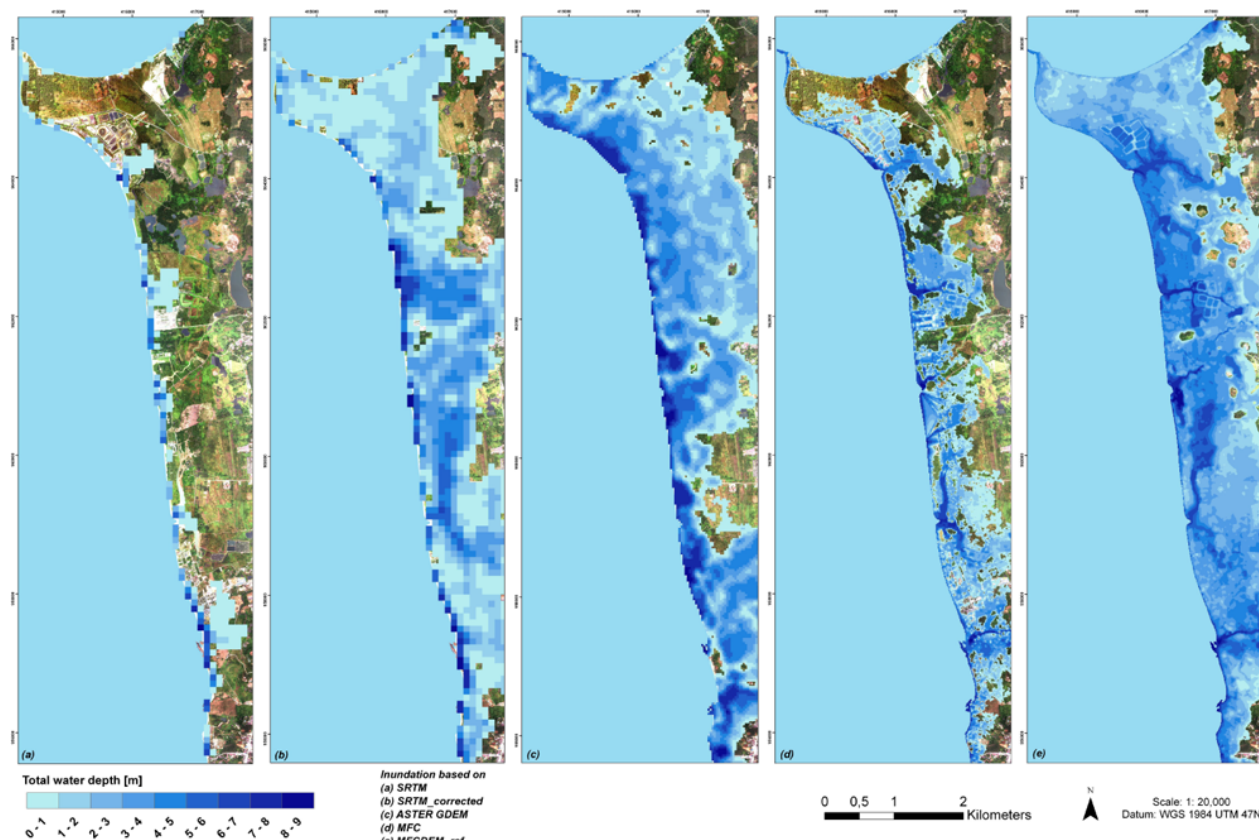
Fig. 8. Maximum total water depth for (a) SRTM, (b) SRTM corrected, (c) ASTER GDEM, (d) MFC, and (e) MFC DEM ref .